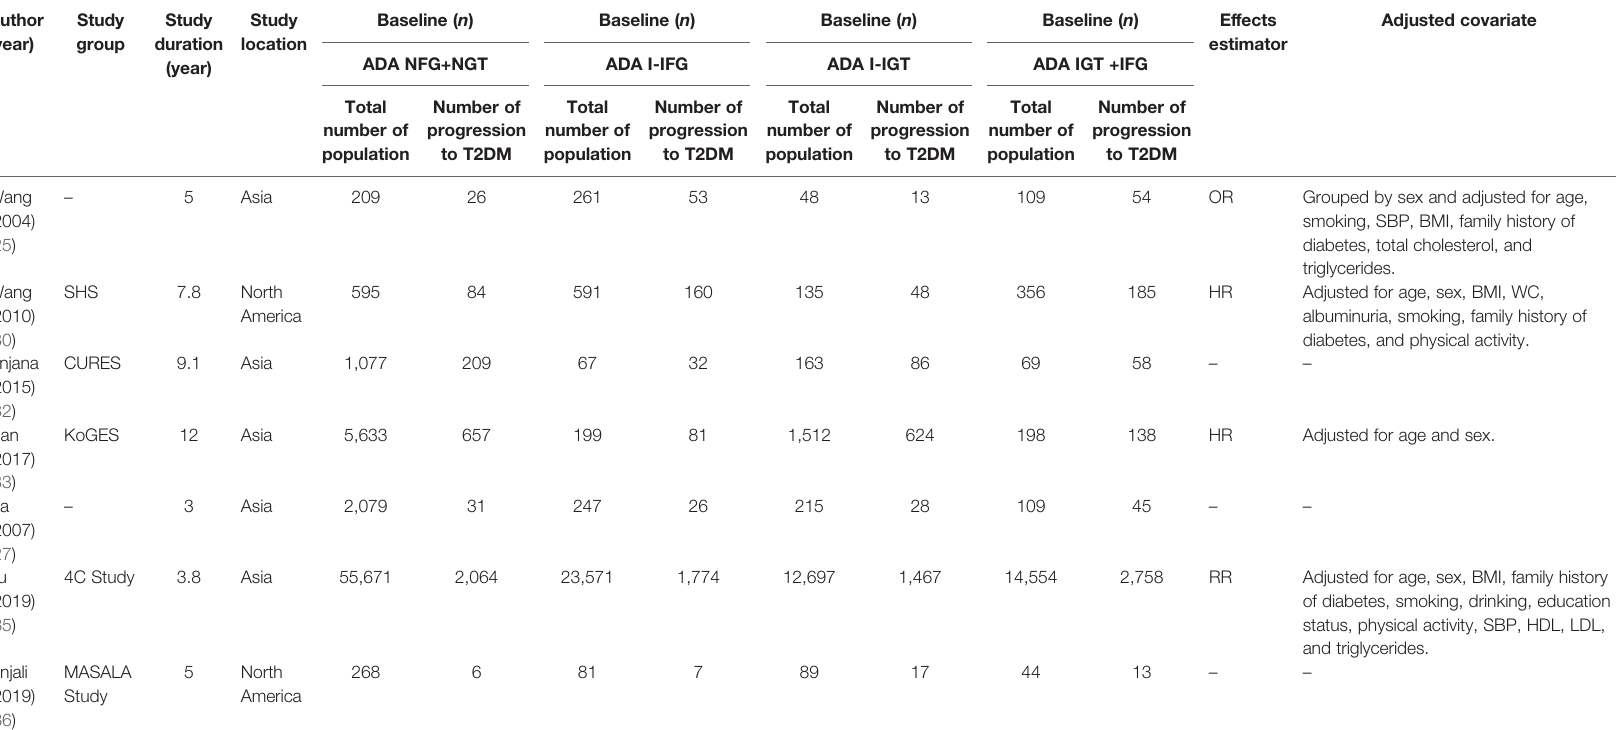
TABLE 2 | Characteristics of the included studies according to the ADA 2003 classi fi cation criteria. Author